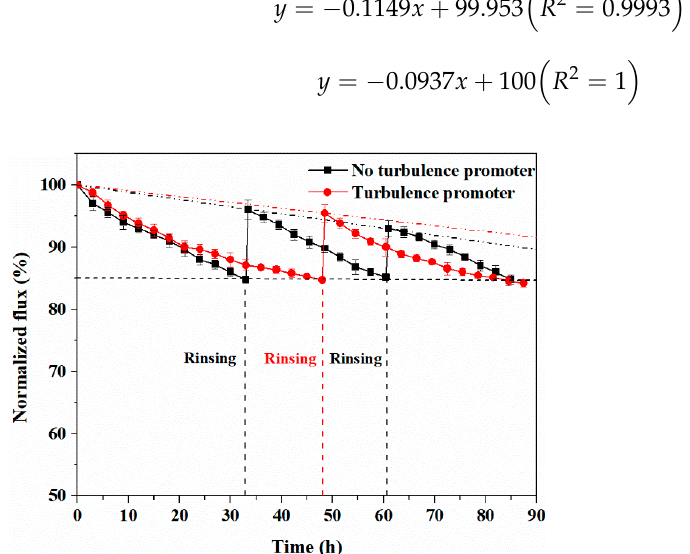
Figure 15. Variations of normalized flux with time (SSTS: 50 ppm HA, pH = 4; TMP = 0.5 MPa).